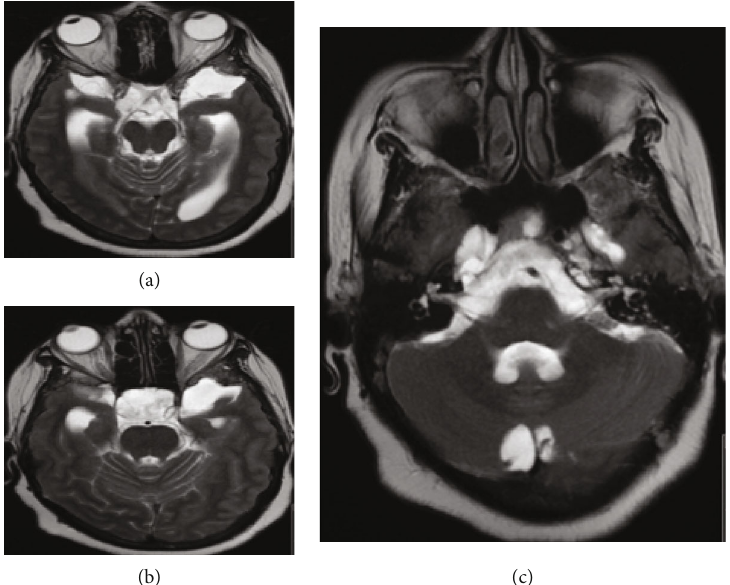
Figure 2: Axial view of a T2-weighted image of the midbrain (a) and upper pons lower midbrain (b) levels showing expanded temporal horns, increase in the subarachnoid space of the optic nerves, optic nerves ’ tortuosity, and deviation of the optic chiasm towards the left side, all indicating high ICP. The middle pons level shows bilateral Meckel ’ s cave expansion and scalloping of the right petrous apex associated with a cephalocele